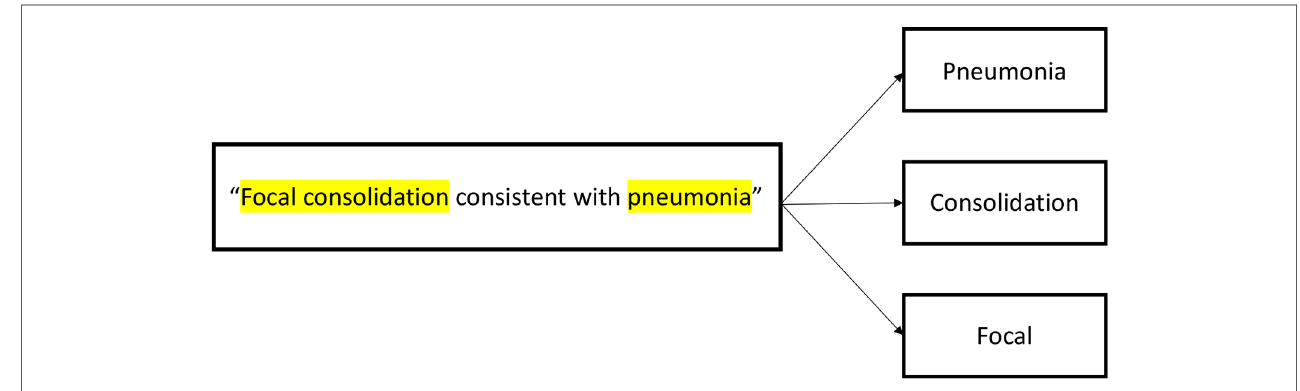
FIGURE 2 A simpli fi ed example of our skip-gram